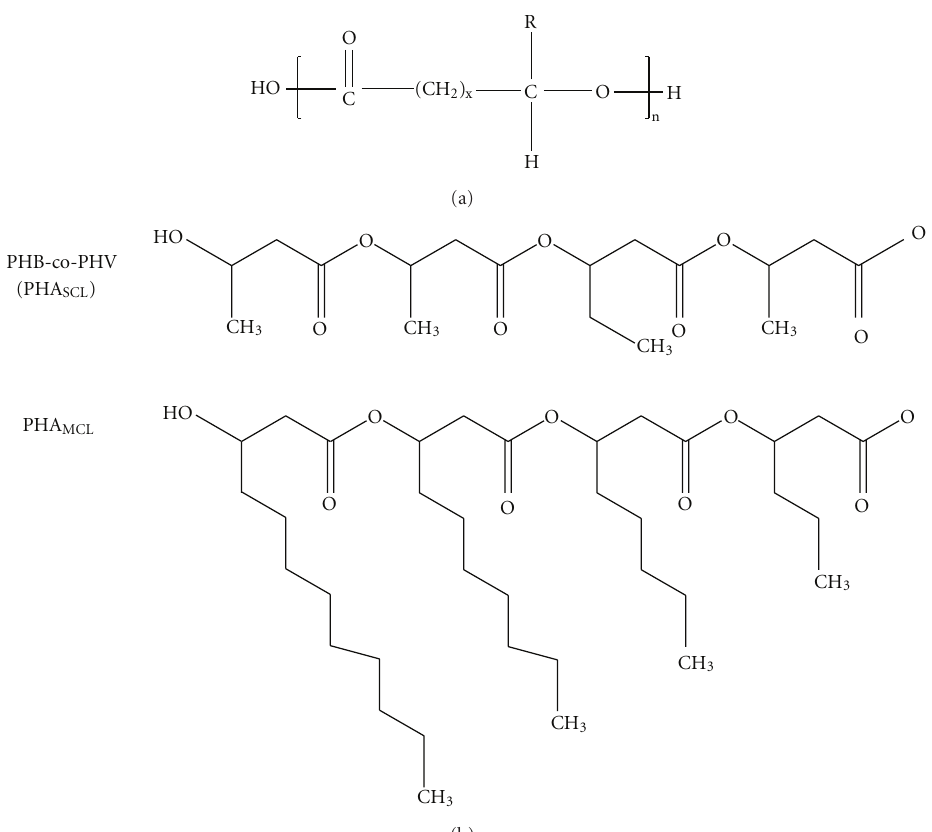
Figure 3: Chemical structure of PHA (a) and other classes (b)